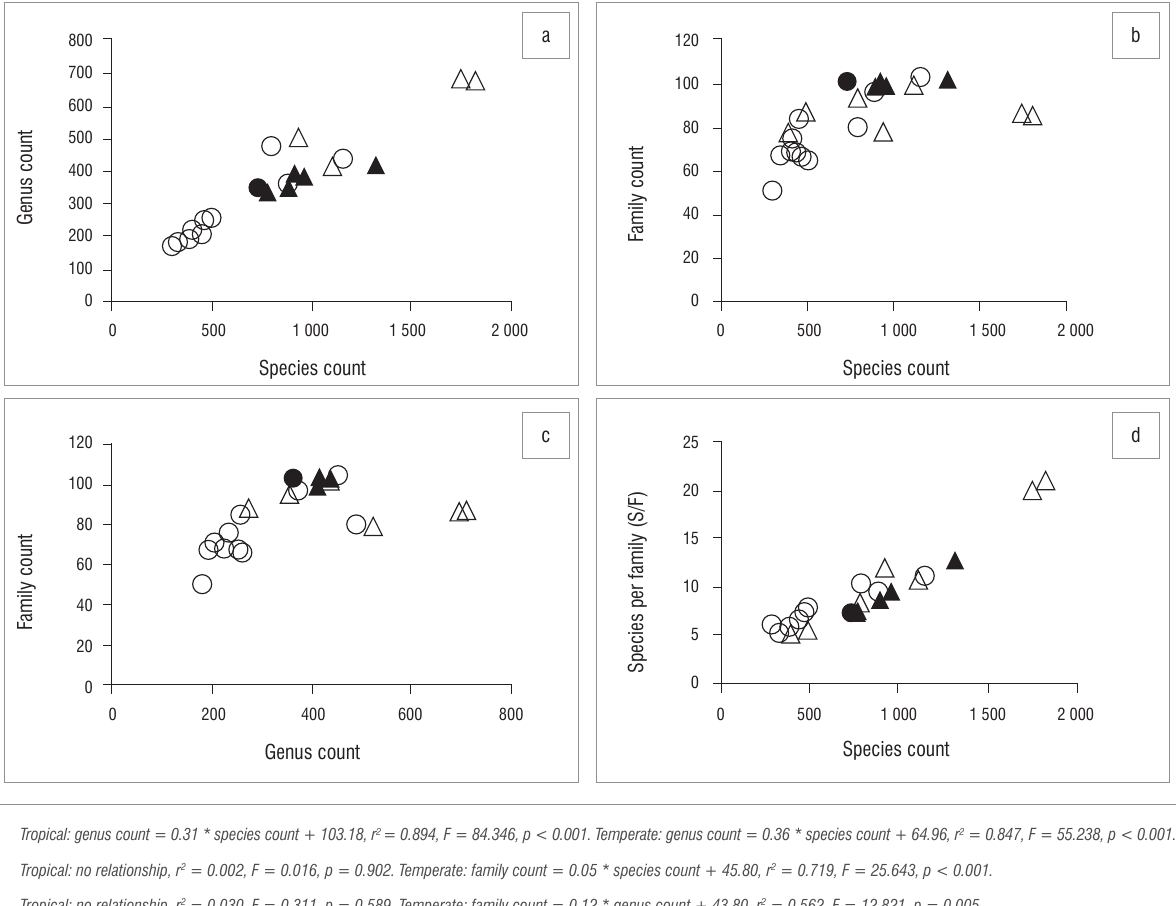
Figure 3: The relationships between (a) genus and species, (b) family and species, (c) family and genus, (d) family size (species:family) and species counts in each region for tropical (triangles) and temperate (circles) regions, with sub-Saharan African regions